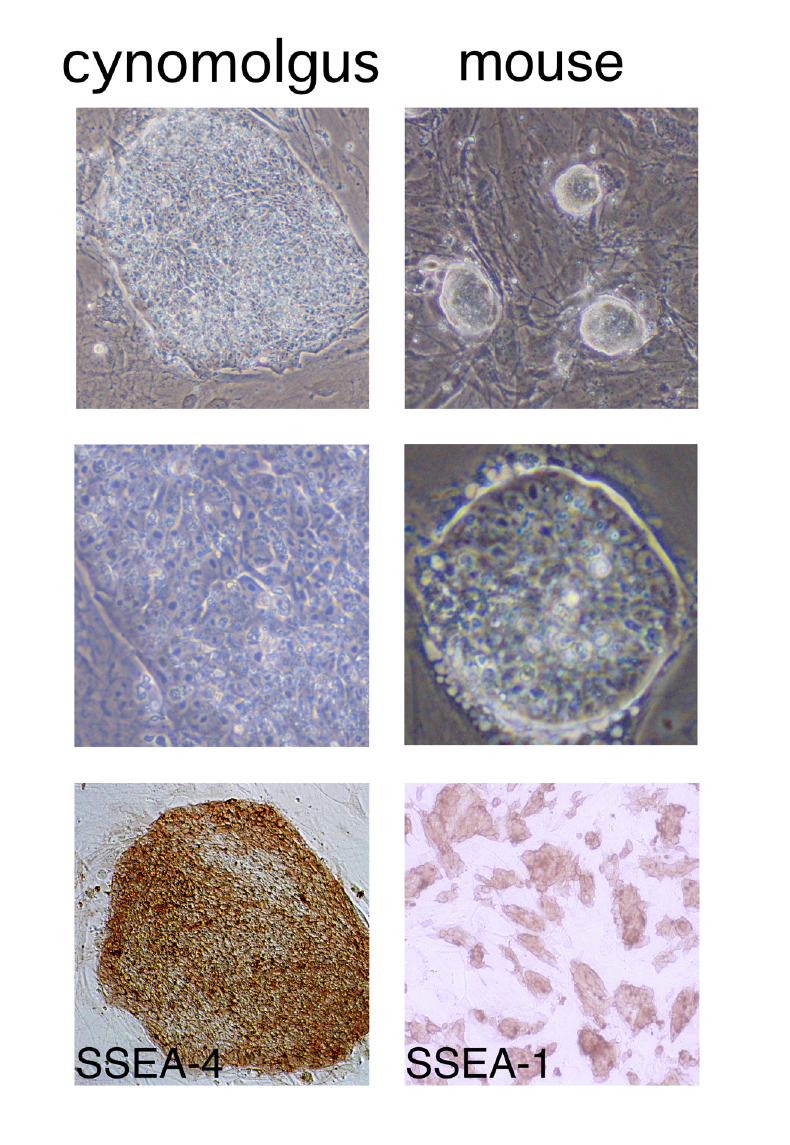
FIGURE 3 . Morphology of cynomolgus monkey and mouse ES cells and expression of SSEA antigens. Monkey ES cells form flatter colonies than mouse ES cell colonies. Also, cell boundaries are visible in the monkey colonies, while the mouse colonies are made of ES cells compacted each other so that individual cells are